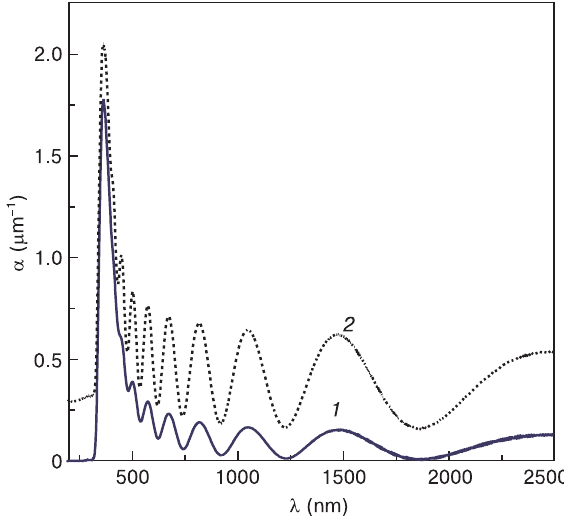
Figure 6. Film absorption spectra ( 1 ) without and ( 2 ) with al - lowance for